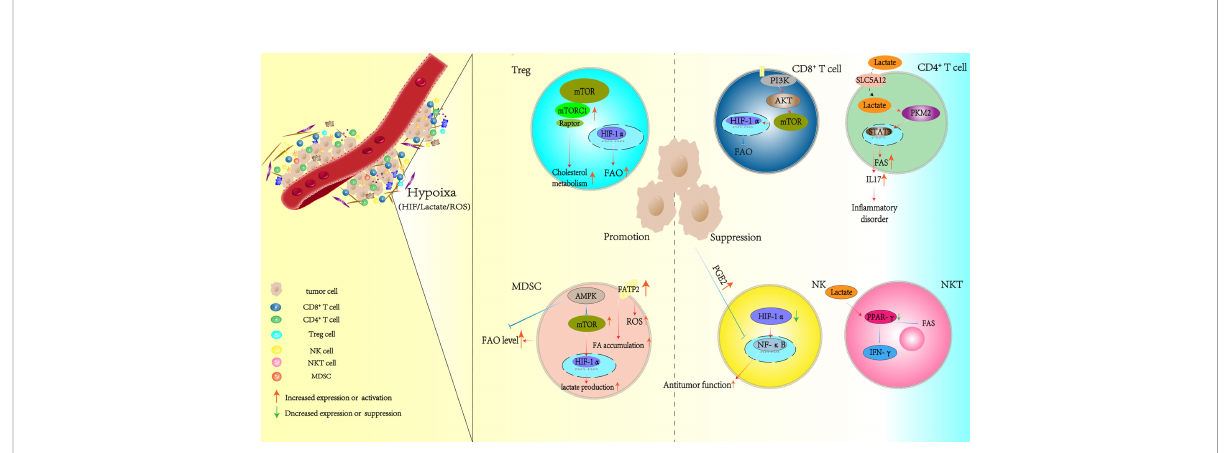
FIGURE 2 Hypoxia alters the lipid metabolism patterns of immunocytes in the TME. TME, tumor